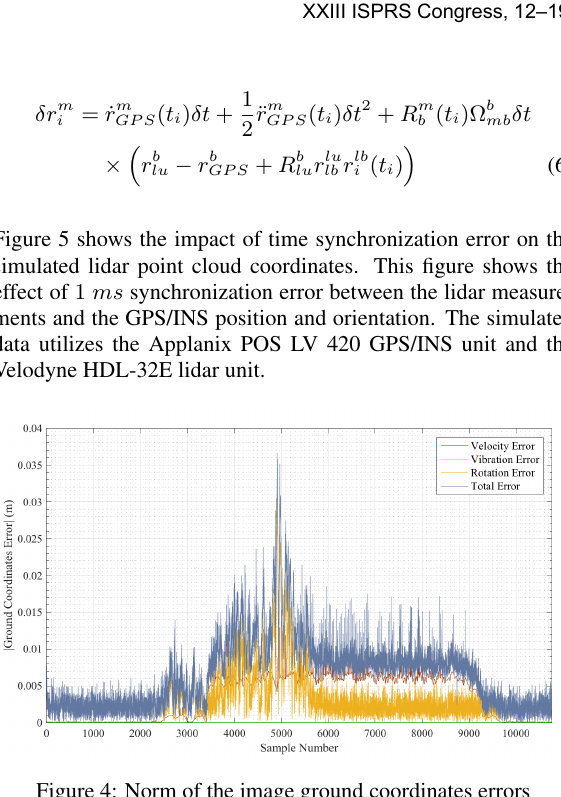
Figure 4: Norm of the image ground coordinates errors